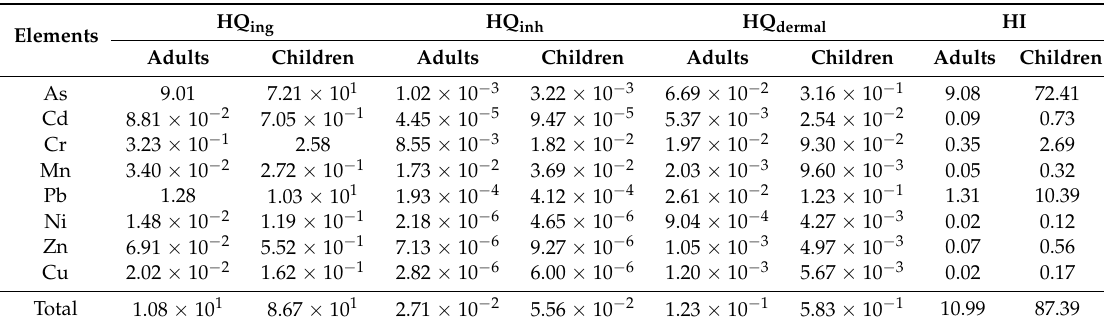
Table 6. Non-cancer risks for each element via three exposure pathways. HQ, hazard quotient; HI, hazard index.